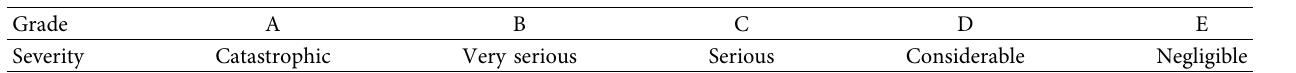
Table 3: Risk loss level standard.